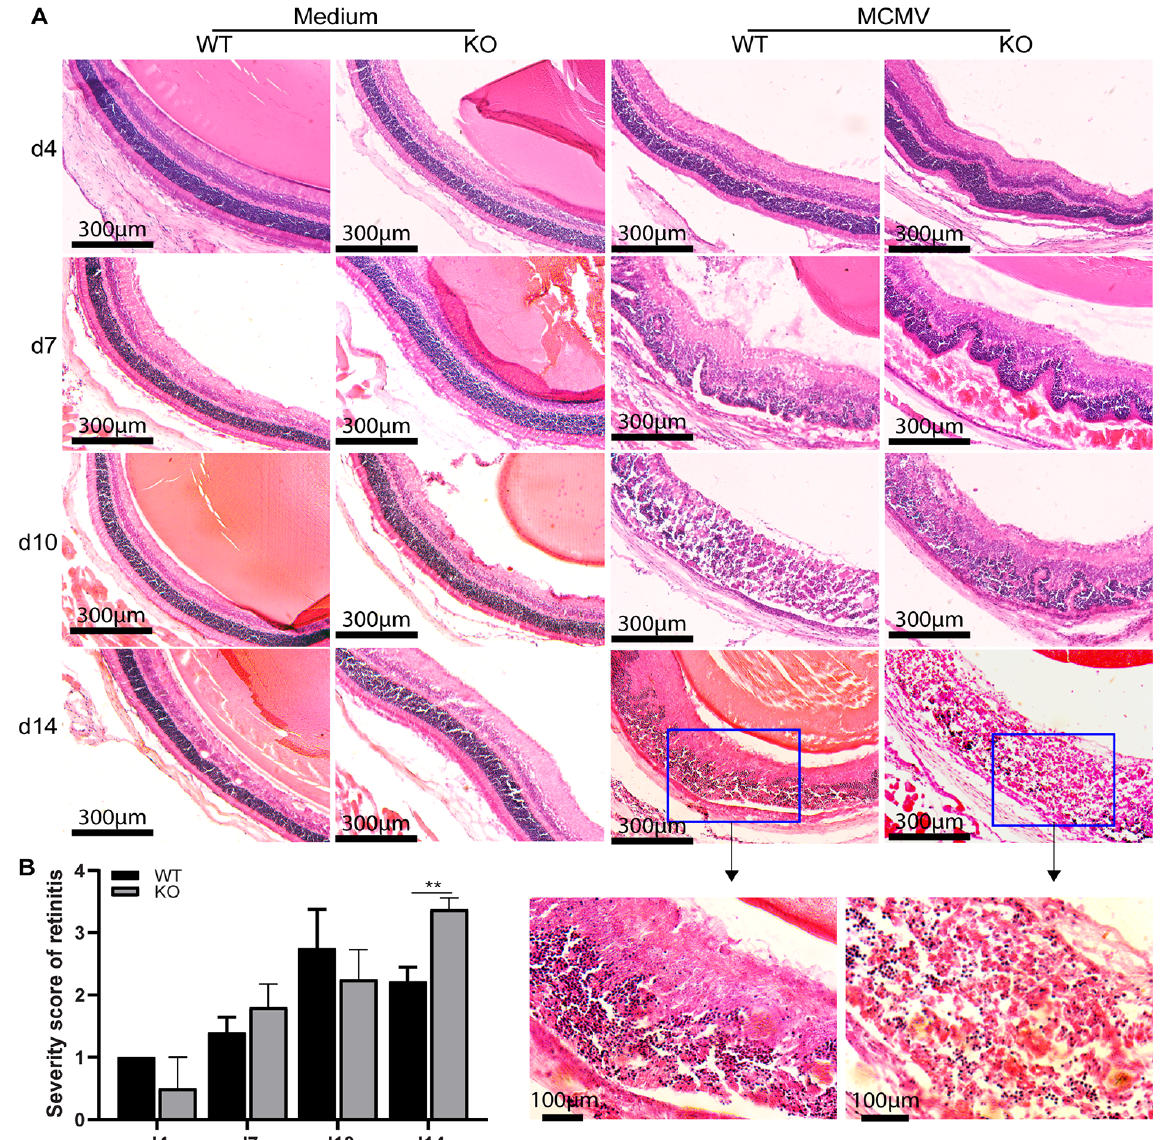
Figure 2. Caspase-12 deficiency exacerbates the severity of MCMV retinitis. ( A ) Representative photomicrographs of H&E staining from MCMV injected eyes of IS WT and KO mice at day 4, 7, 10, and 14 p.i. ( B ) Scoring of retinitis in MCMV-infected eyes of IS WT and KO mice at day 4 ( n = 3), 7 ( n = 5), 10 ( n = 4), and 14 ( n = 8) p.i. Data are shown as mean ± SEM. Statistical analysis by 2-tailed t-test. ** p < 0.01.